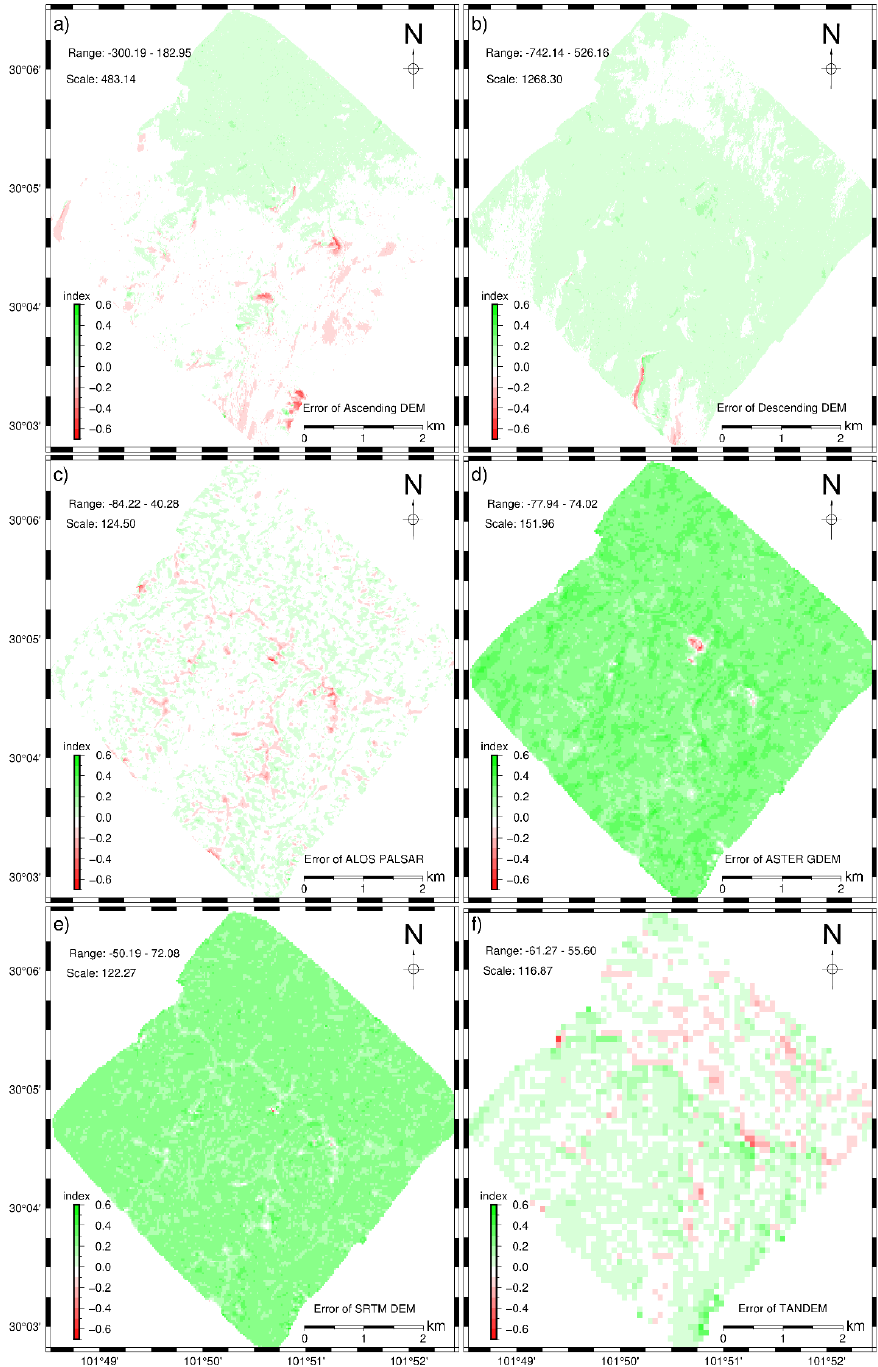
Figure 7. Errors and normalized error indexes of the DEMs based on the reference DSM: ( a – f ) correspond to errors in the spatial distribution maps of the ascending InSAR DEM (with a resolution of 13.96 m), descending InSAR DEM (with a resolution of 13.96 m), ALOS PALSAR DEM (with a resolution of 12.5 m), ASTER Global DEM V3 (with a resolution of 30 m), SRTM V3 DEM (with a resolution of 30 m), and TanDEM (with a resolution of 90 m), respectively. On the top left, the scale represents the scaling factor and the range indicates the error value range. The actual error value is the product of scale and index.